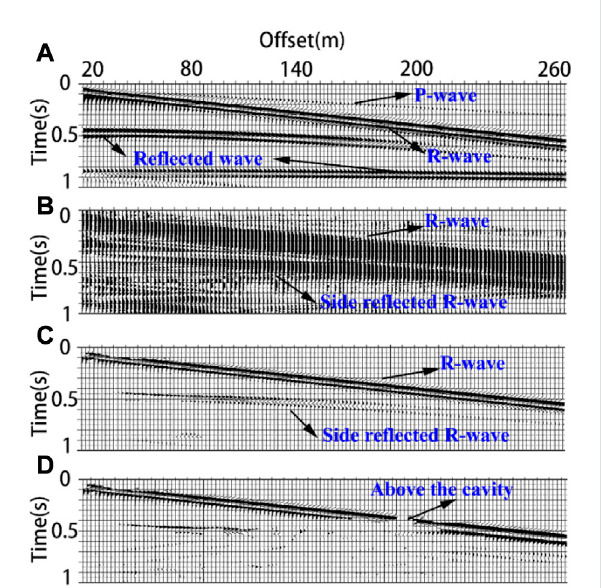
FIGURE 5 Seismic record. (A) Is theoriginal seismic record simulated bythe homogeneous half-space model; (B) Is the corresponding instantaneous phase difference between the horizontal component and the vertical component, (C, D) are the phase difference fi ltering results of seismic records of homogeneous model and transverse inhomogeneous model